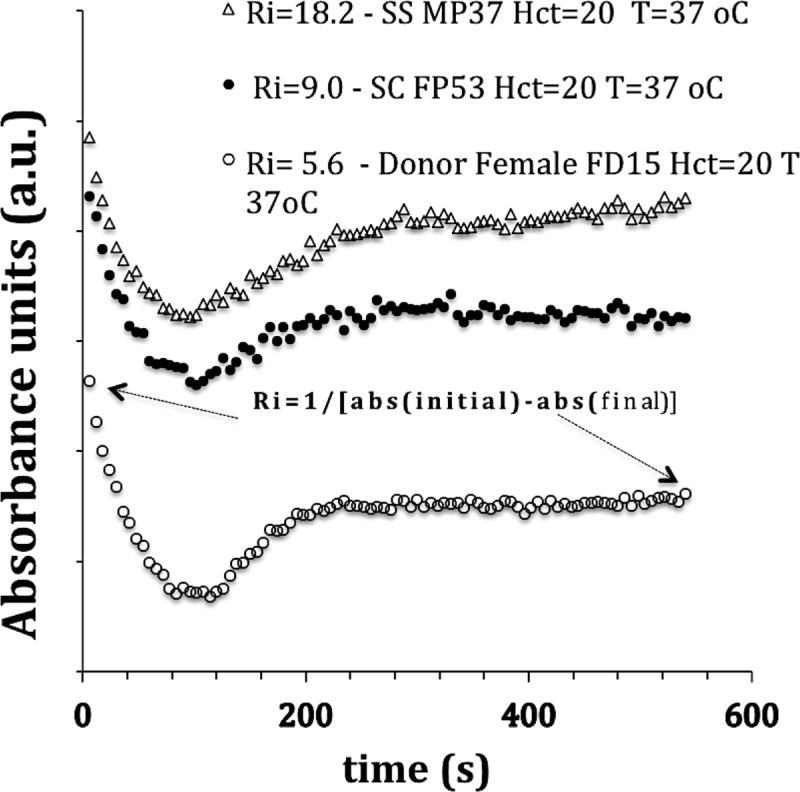
Microplate Reader essays (absorbance, a.u.) performed to calculate (semi-quantitative) RBC Ri rigidity index values in a) sample of a male donor (p <0.001), b) SS male patient (p <0.001) and c) SC female patient (p <0.001); Hct = 20 (0.2 l/l) in the all essays. The value of the RBC rigidity index Ri is lower for the donors. The difference between the initial and final absorbance values is higher for the donors because the deformable red cells form rouleaux and allow more light to pass (greater transmittance) at the end of the sedimentation process inside the microwell. When sedimentation finally ends, the absorbance is constant because the rouleaux are stable.